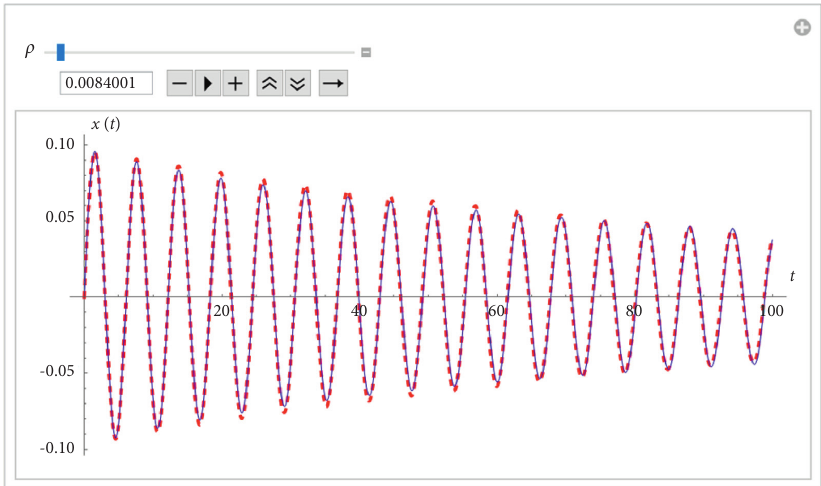
Figure 5: Comparison between the analytical approximant (49) and the Runge–Kutta numerical solution for the i.v.p